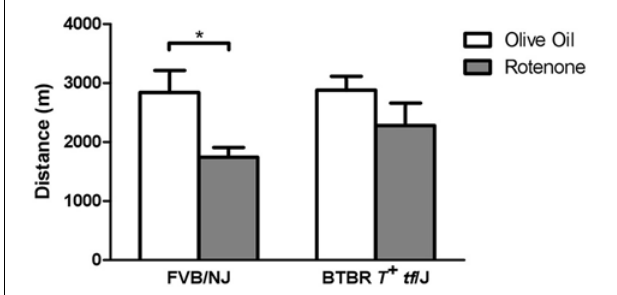
FIGURE 5 | In vivo validation of Cybb in rotenone toxicity using the treadmill exhaustion test. Two inbred mouse strains were tested for distance traveled during a 3.5h time span in the stress treadmill test. The mice treated with vehicle ( n = 6 per strain) showed similar distances for the two strains; however, FVB/NJ mice treated with rotenone ( n = 6) had a larger performance decrease than BTBR T + tf /J mice ( n = 6) ∗ p < 0 . 05. Data are expressed as means ± SE .